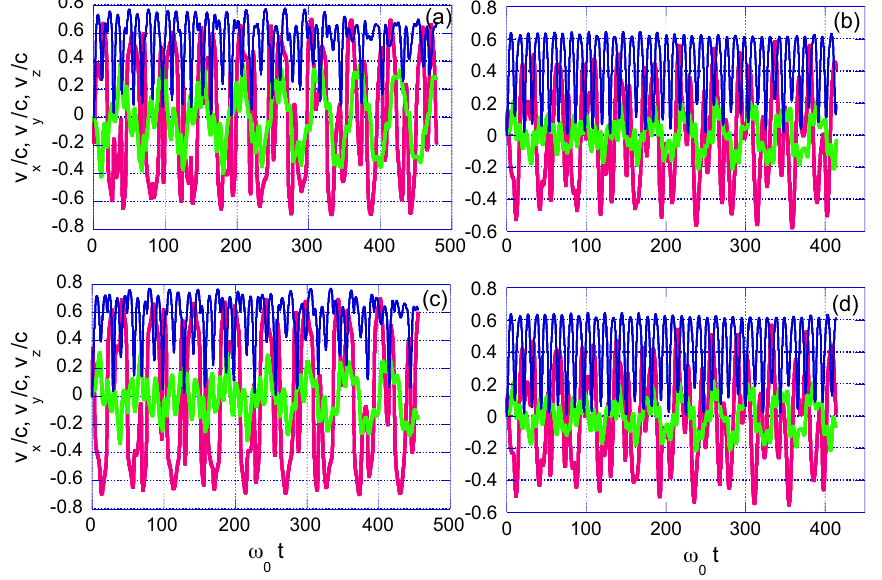
Figure 8. Temporal evolution of v x ( t ) / c (in red) and v y ( t ) / c (in green) and v z ( t ) / c (in blue). The same cases as in Figure 6 are